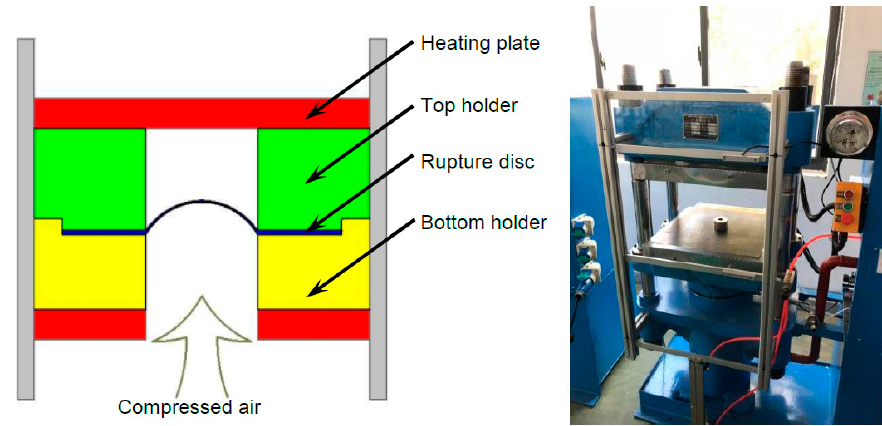
Figure 2. A schematic diagram (left) and the bursting test set-up (right).